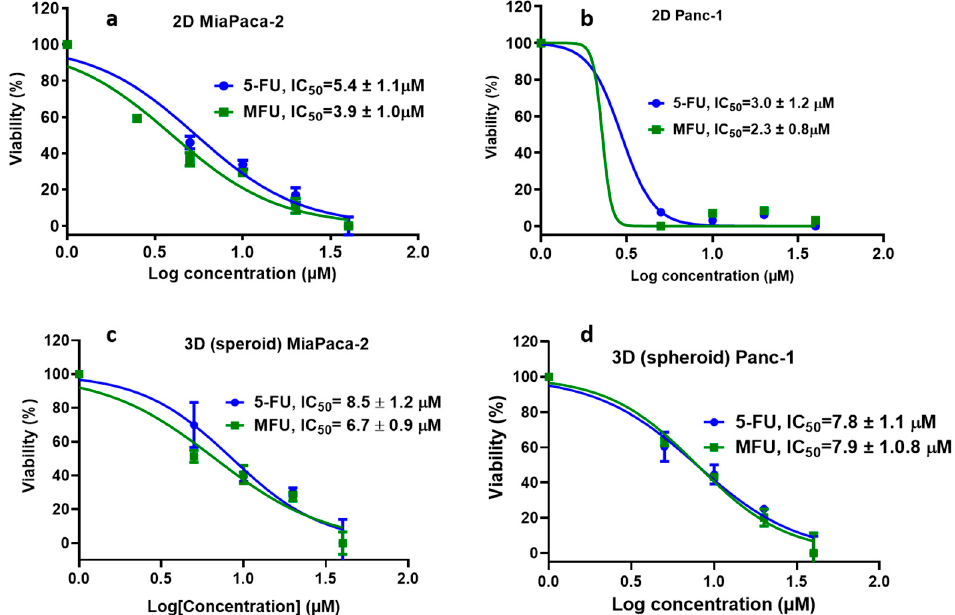
Figure 4. In vitro studies comparing the efficiency of 5-FU and free MFU. ( a ) 2D culture of MiaPaca-2 cells, ( b ) 2D culture of Panc-1 cells, ( c ) 3D culture of Miapaca-2 cells, and ( d ) 3D culture of Panc-1 cells.